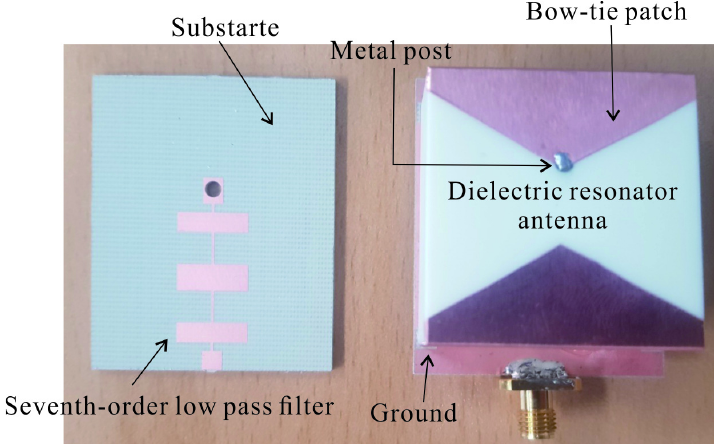
Figure 10. Fabricated shape and configuration of the proposed antenna.